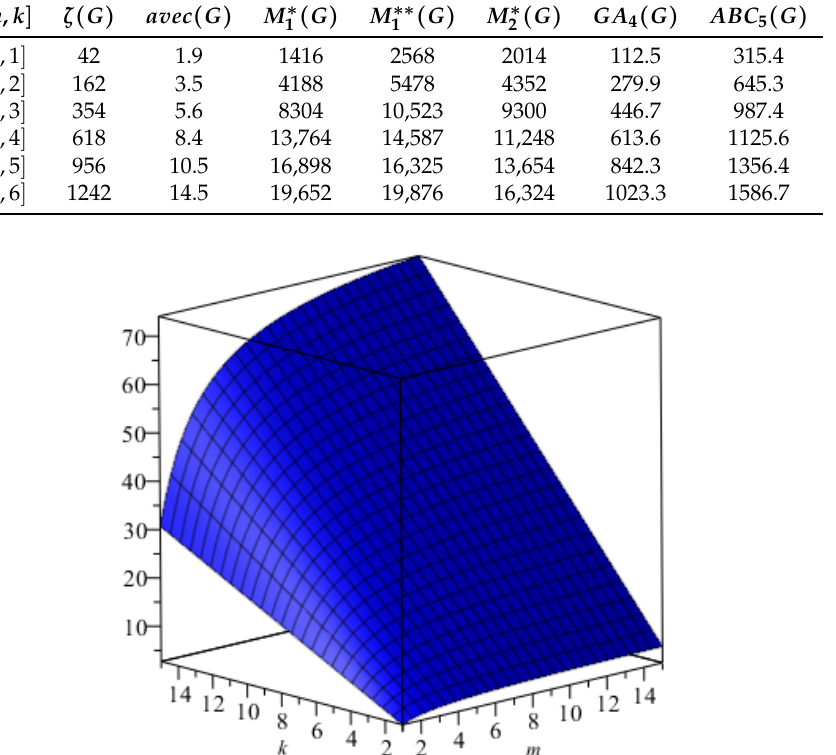
Figure 4. The graphically representation of the first Zagreb eccentricity index M ∗